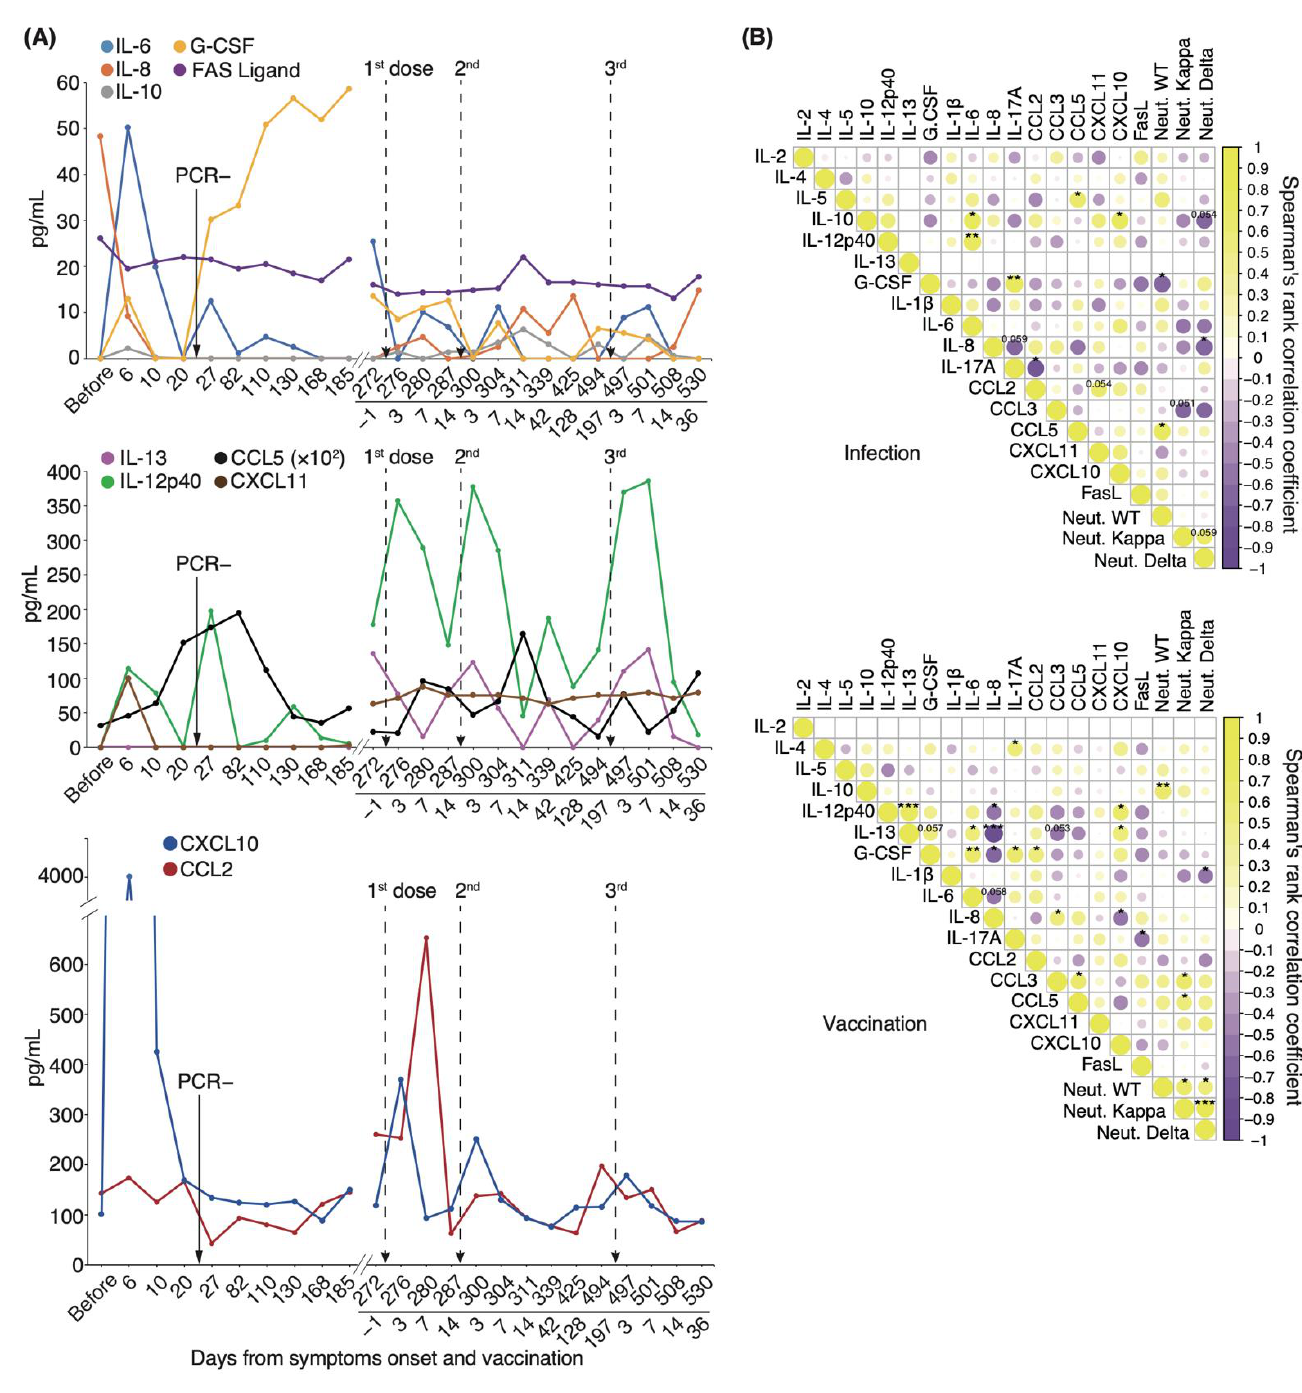
Figure 6. Longitudinal analysis of serum cytokine levels associated with neutralizing potency: ( A ) Representative cytokine, chemokine, and interleukin level fluctuation from onset to post- vaccination. ( B ) Correlation matrix on the left shows the time of infection from symptom onset to 185 days, and that on the right shows the vaccination period from 1 day before the first vaccination to 36 days after the third vaccination ( n = 1). Neutral. WT, neutralizing potency for WT strain; Neutral. Kappa, neutralizing potency for Kappa strain; Neutral. Delta, neutralizing potency for Delta strain; * p < 0.05; ** p < 0.01; *** p < 0.005.